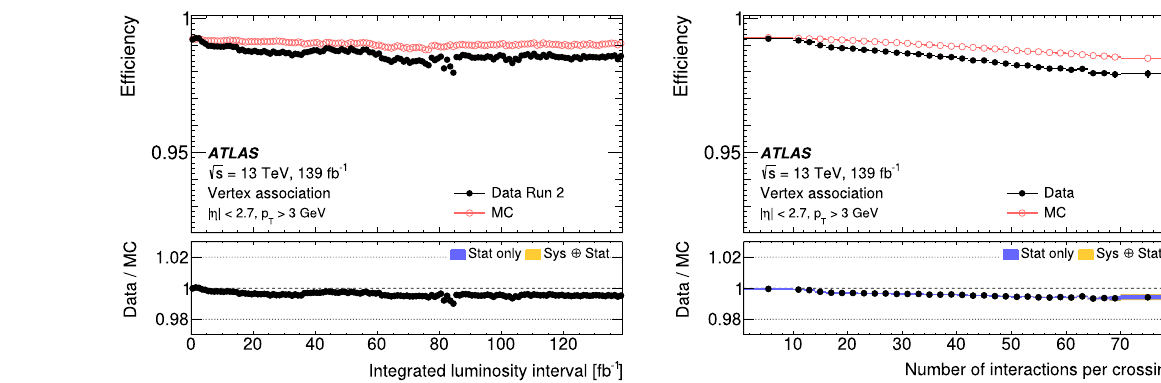
Fig. 23 Efficiency for the vertex association criteria measured in Z → μμ events as a function of the integrated luminosity interval (left) and the actual number of interactions per bunch crossing (right) formuonswith p T > 3GeV.Intheleftploteachdatapointcorresponds to 1 fb − 1 of collected data in Run 2. The statistical uncertainty in the efficiency measurement is smaller than the size of the markers, and thus